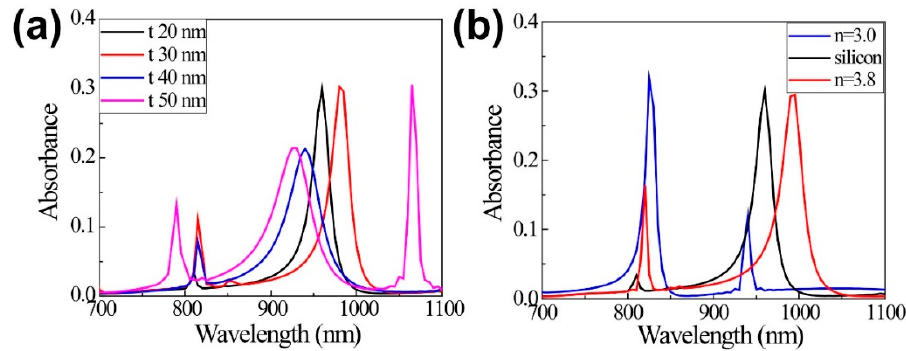
Figure 3. ( a ) Absorption spectra for different slot widths ( t ). Here, width of 380 nm and height of 200 nm are used. ( b ) Absorption spectra for different refractive indexes (n) of the block material.